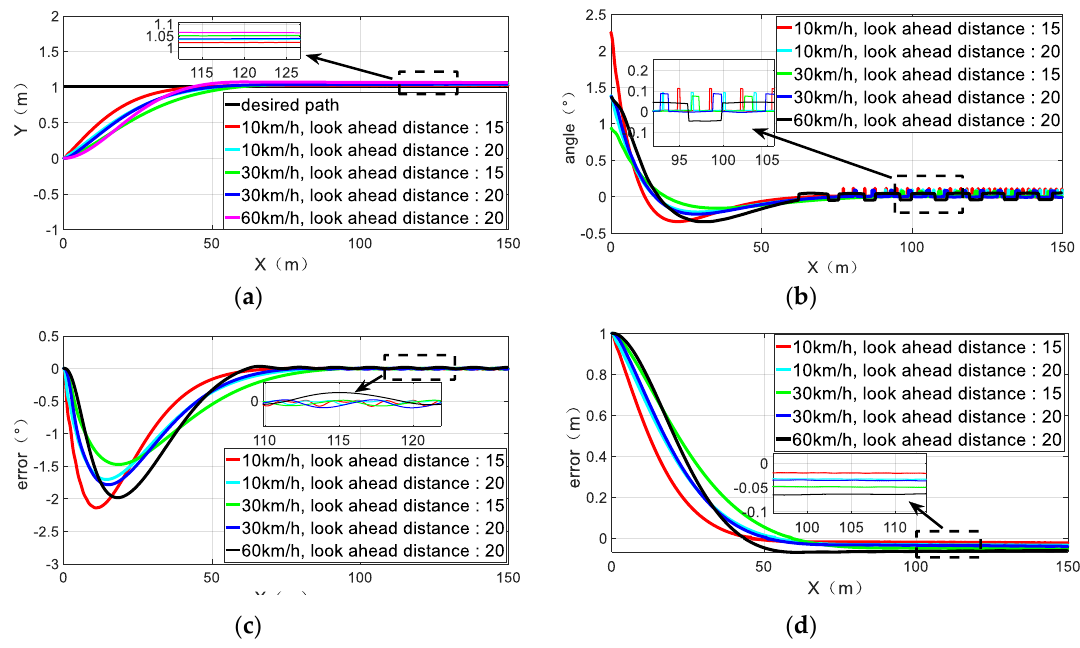
Figure 14. Control performance of PPC-RAR. ( a ) Desired path and the bus’s path under different conditions. ( b ) Steering angle. ( c ) Heading error. ( d ) Lateral error.